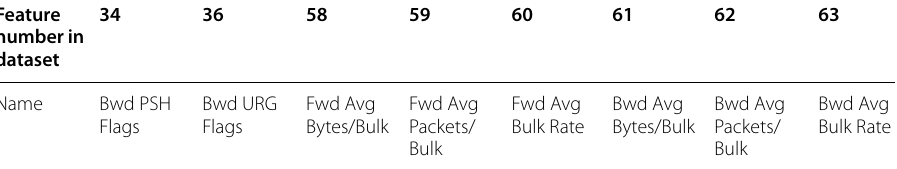
Table 7 Invalid features of CICIDS dataset Feature number